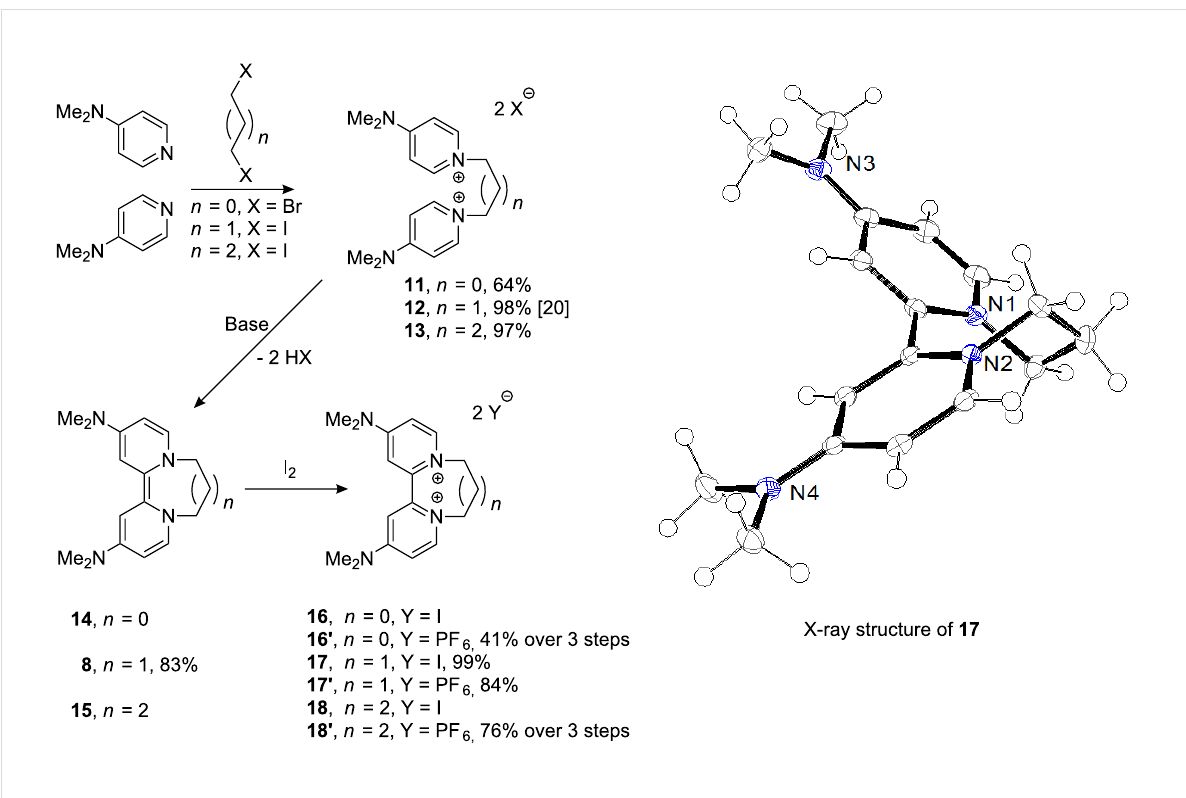
Figure 2: Formation of donors and oxidation to form diiodide salts, together with the ORTEP diagram of diiodide salt 17 (only the cation is